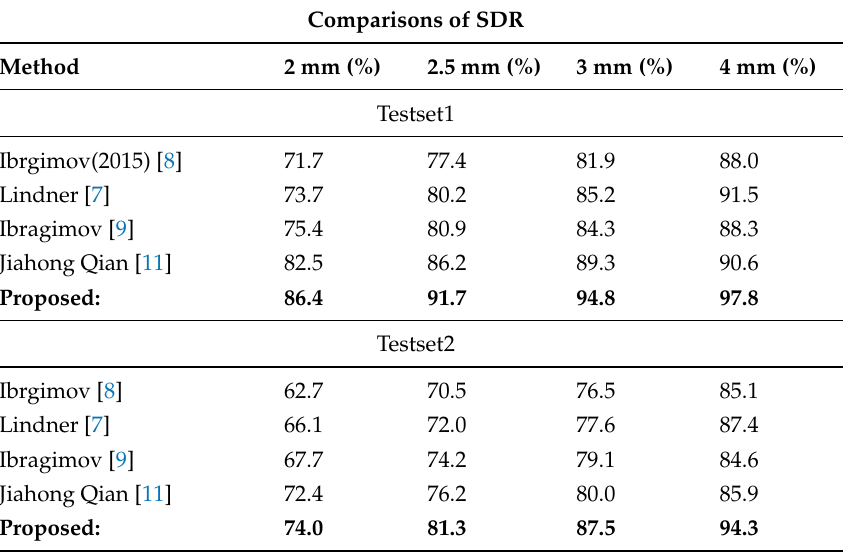
Table 3. SDR of the proposed method compared with other benchmarks for ISBI 2015 challenges on cephalometry landmark detection Testset1 and